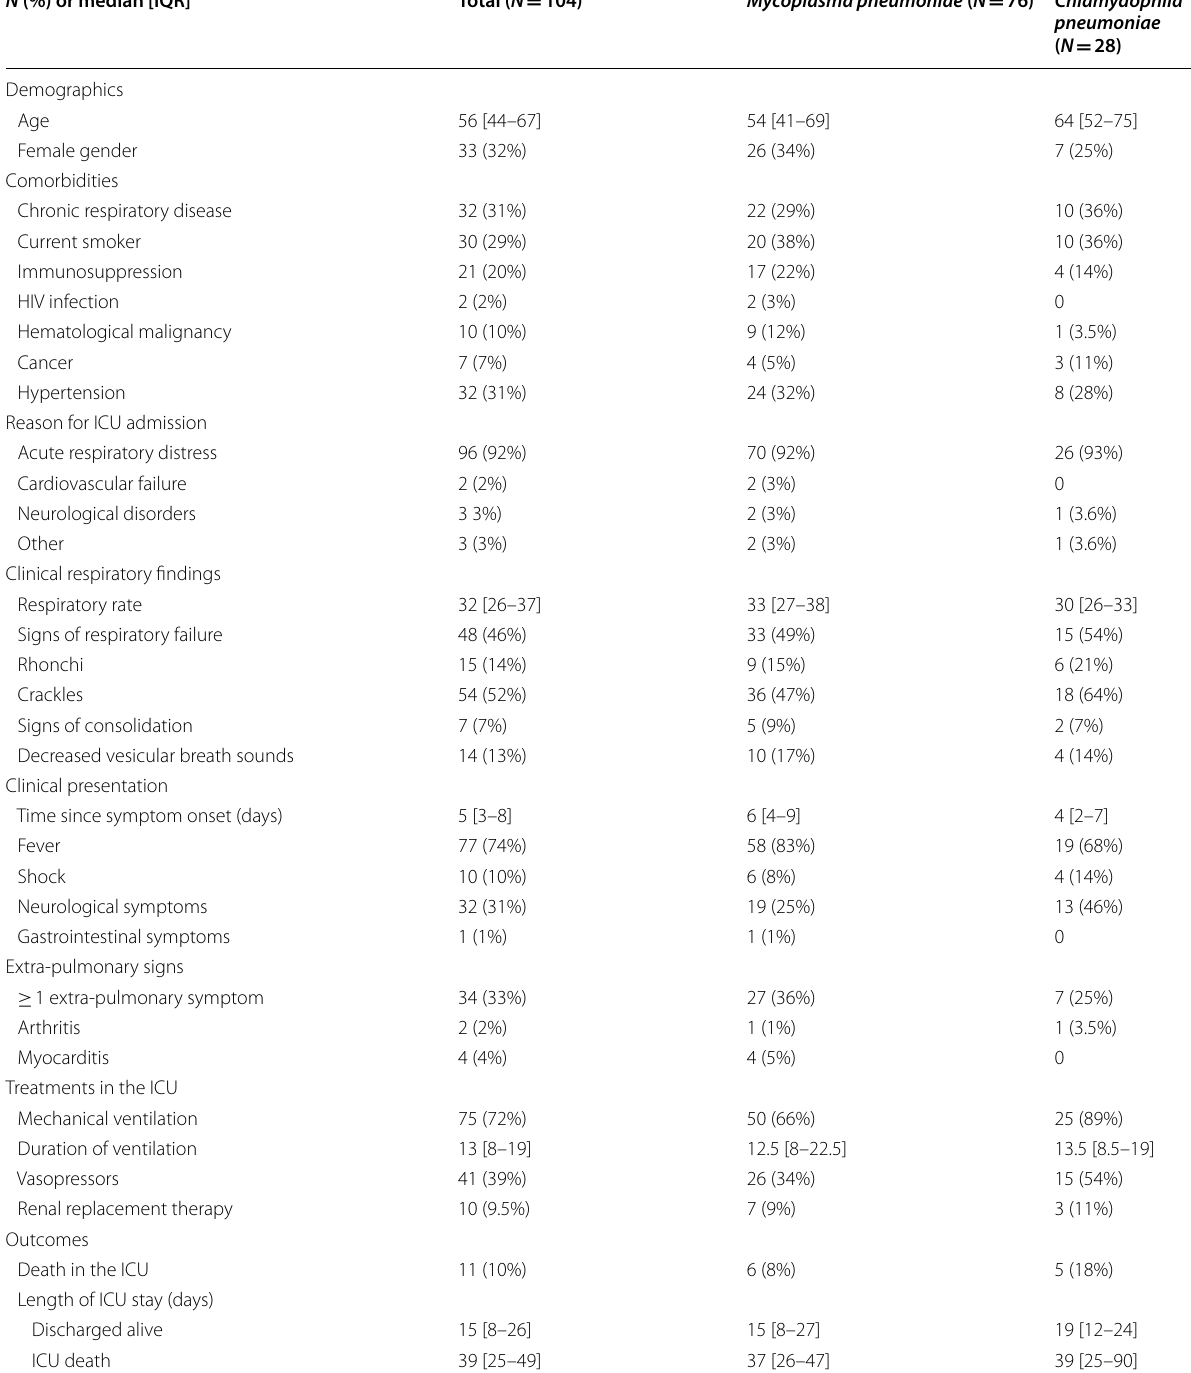
Table 1 Clinical characteristics of patients with atypical pneumonia at ICU admission and outcome according to the causative